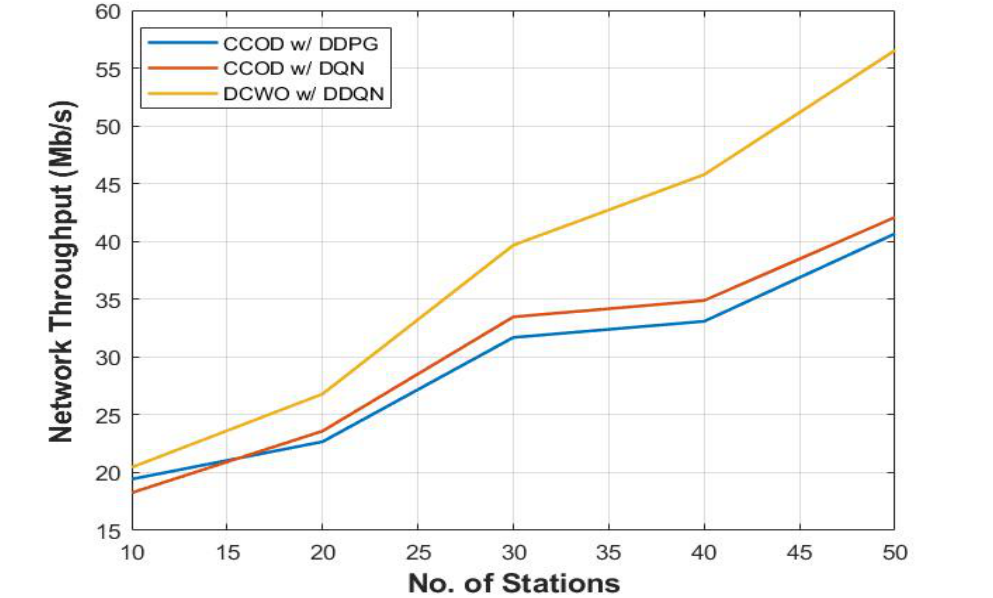
Figure 8. Network Throughput for Dynamic Scenario.